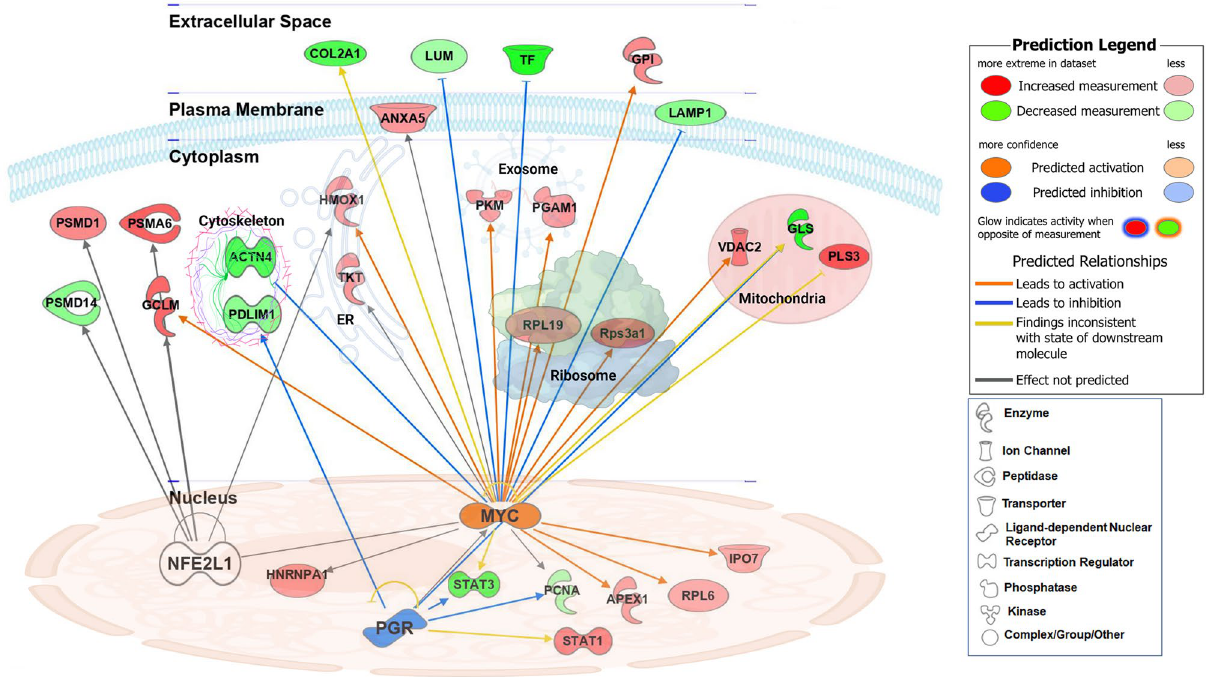
Figure 2. Interconnected proteins and predicted upstream regulators built with IPA program for DE protein data that was determined on BCO-affected tibiae. IPA analysis predicted MYC, PR (PGR), and NRF1 (or NFE2L1) as upstream regulators, which were assigned as inhibited or activated according to Z-score. ACTN4, α-actinin 4; ANXA5, annexin A5; APEX1, Apurinic/Apyrimidinic Endodeoxyribonuclease 1; Col2A1; Collagen Type II Alpha 1 Chain ; GCLM; Glutamate-Cysteine Ligase Modifier Subunit ; GLS; Glutaminase; HMOX1; Heme Oxygenase 1; HNRNPA1; Heterogeneous Nuclear Ribonucleoprotein A1; IPO7; Importin 7; LAMP1; Lysosomal Associated Membrane Protein 1; LUM; Lumican; MYC; Myelocytomatosis Oncogene; NFE2L1; NFE2 Like BZIP Transcription Factor 1; PCNA; Proliferating Cell Nuclear Antigen; PGAM1; Phosphoglycerate Mutase 1; PGR (PR); progesterone receptor; PKM; Pyruvate Kinase M1/2; PLS3; plastin 3; PSMA; Proteasome 20S Subunit Alpha 6; PSMD; Proteasome 26S Subunit, Non-ATPase 1; RPL; Ribosomal Protein L6; RPS; ribosomal protein S3A1; STAT; Signal Transducer And Activator Of Transcription; TF; Transferrin; VDAC2, voltage-dependent anion channel